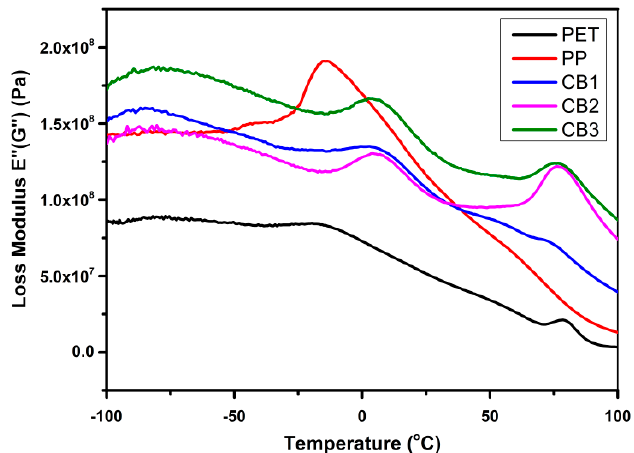
measured by DMA dual cantilever in bending